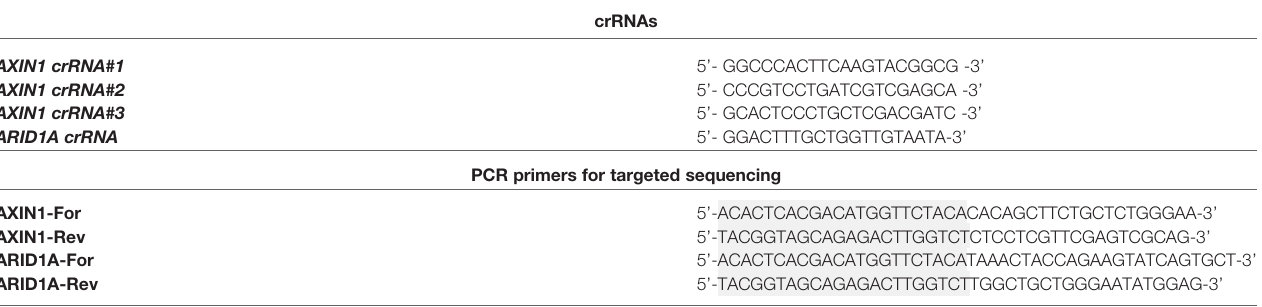
TABLE 1 | Oligonucleotides used in the